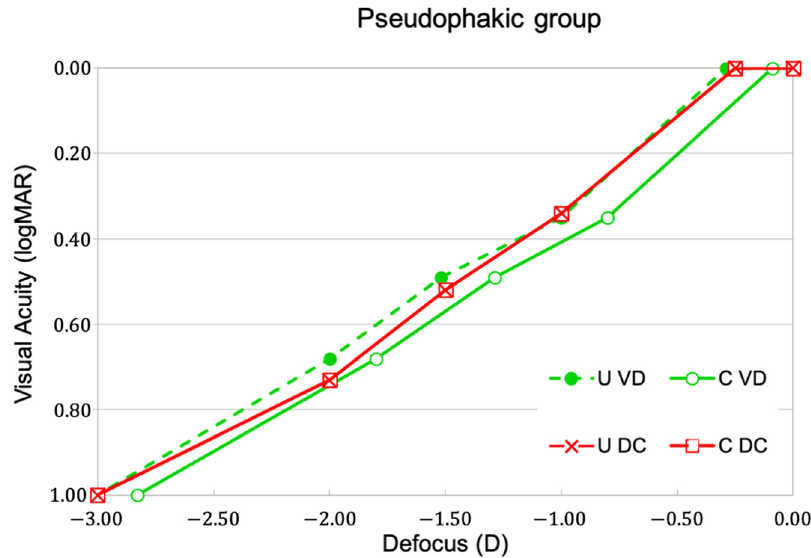
Figure 4. Visual acuity (logMAR) versus defocus that was obtained with VD and DC methods for the monofocal pseudophakic group: uncorrected (U) results and results that were corrected (C) for the starting position of the chart (5 m) and the diminution of minus lenses. All the measurements were taken with the best distance correction.